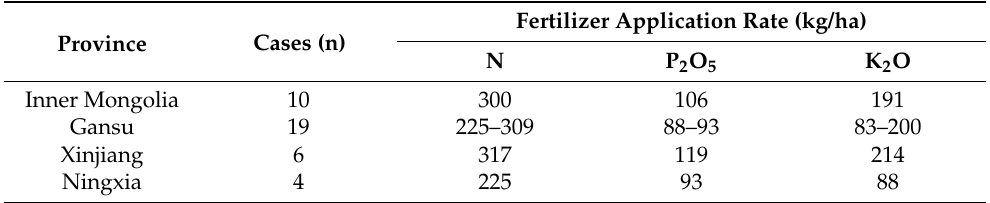
Table 2. Rates of fertilizer application for nutrient expert